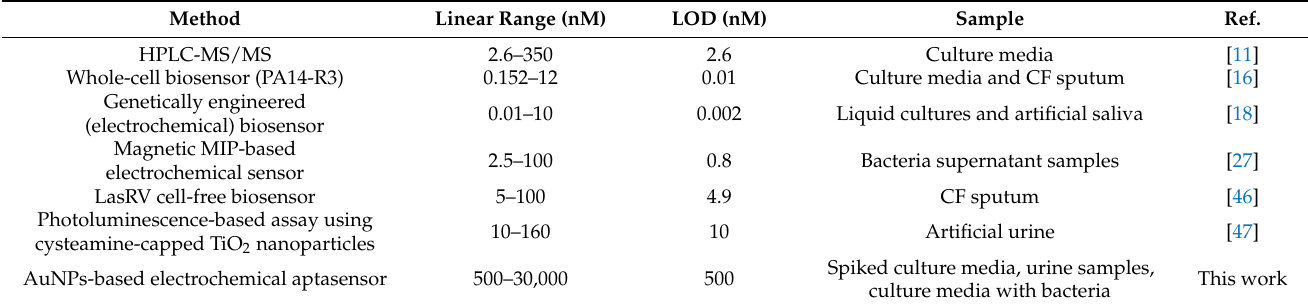
Table 4. Comparison of this aptasensor with other methods previously reported for 3-O-C 12 -HSL